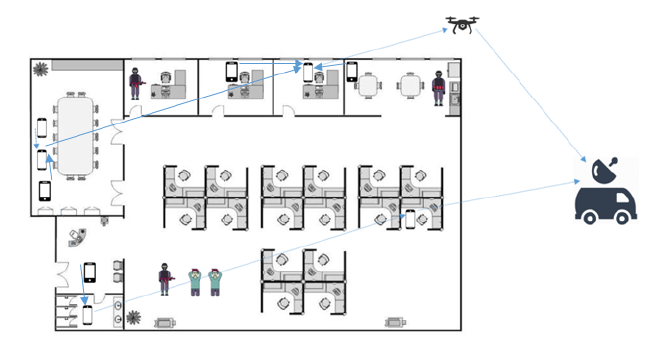
Figure 2. Disaster hit area with Unmanned Aerial Vehicle (UAV) and Command Center